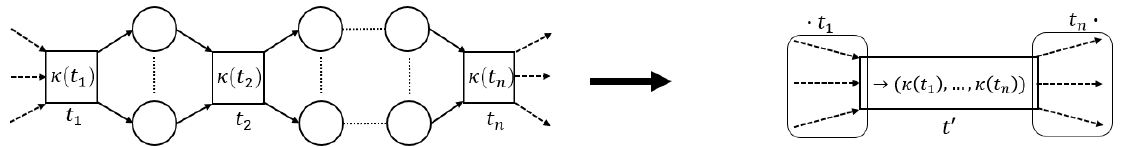
Figure 9. Schematic visualization of the → -pattern reduction (dashed arcs are allowed to be part of the pattern, solid arcs are required). The post-set of each transition t i acts as the pre-set of t i + 1 (1 ≤ i < n ). The transition t (cid:48) replacing the identified pattern inherits • t 1 and t n • (these corresponding places are not explicitly visualized in this figure). The label of t (cid:48) is formed by the sequence operator defined on top of the labels of t 1 ,..., t n ,